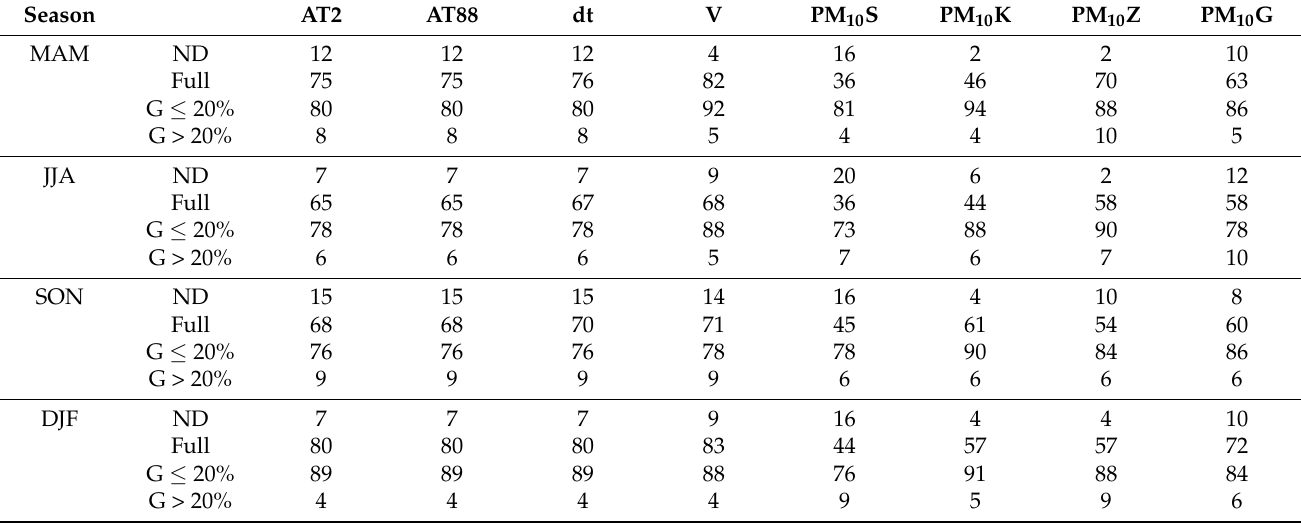
Table 2. Characteristic of hourly data completeness expressed as a percentage of seasons [%]